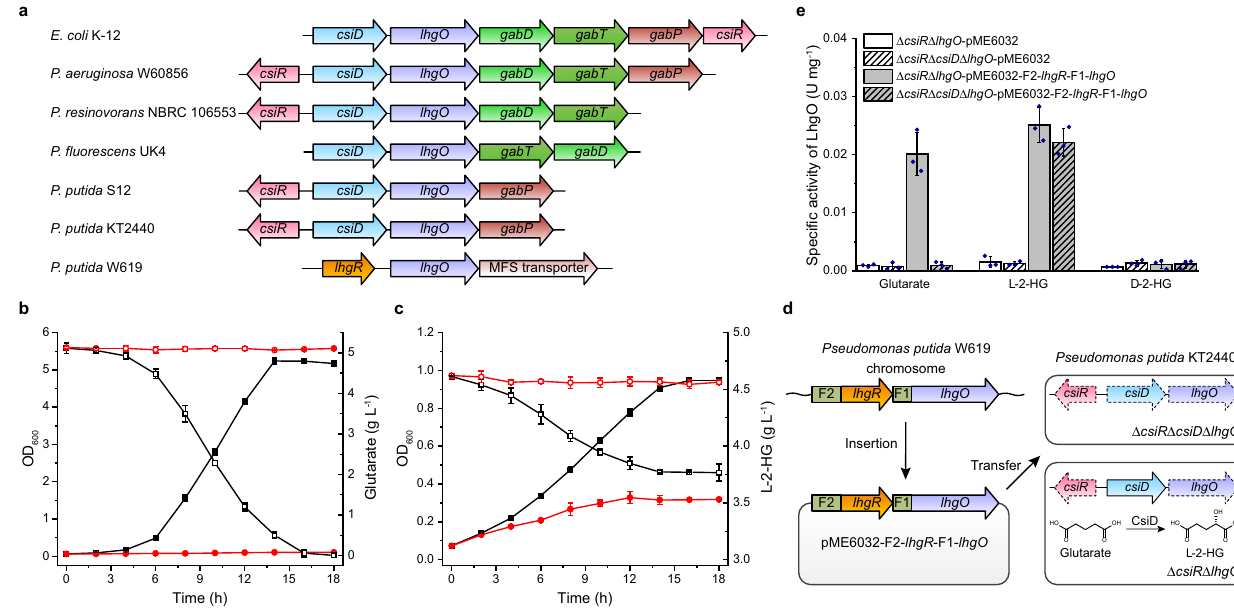
Fig. 1 Regulation of L -2-HG catabolism by LhgR in P. putida W619. a Schematic representation of genomic neighborhood analysis of lhgO in different bacteria. Orthologs are shown in the same color and the direction of gene transcription is indicated by arrows. CsiR, GntR family allosteric transcription factor regulating glutarate catabolism; CsiD, glutarate hydroxylase; LhgO, L -2-HG oxidase; GabD, succinate semialdehyde dehydrogenase; GabT, 4- aminobutyrate aminotransferase; GabP, 4-aminobutyrate transporter. b , c Growth of the derivatives of P. putida KT2440 in MSMs with glutarate ( b ) or L -2- HG ( c ) as the sole carbon source. Growth (closed symbols) and the consumption of carbon source (open symbols) of P. putida KT2440 ( Δ lhgO ) harboring plasmid pME6032- lhgO (black lines with squares) and P. putida KT2440 ( Δ lhgO ) harboring empty plasmid pME6032 (red lines with circles) were measured in MSMs containing 5 g L − 1 glutarate ( b ) or L -2-HG ( c ) as the sole carbon source. d Schematic representation of the construction of pME6032- F2- lhgR -F1- lhgO and its transfer into P. putida KT2440 ( Δ csiR Δ lhgO ) and P. putida KT2440 ( Δ csiR Δ csiD Δ lhgO ) by electroporation. The deleted genes in P. putida KT2440 are indicated by dashed lines. The reaction catalyzed by CsiD is also demonstrated. e The activities of LhgO in P. putida KT2440 ( Δ csiR Δ lhgO ) and P. putida KT2440 ( Δ csiR Δ csiD Δ lhgO ) harboring either plasmid pME6032-F2- lhgR -F1- lhgO or empty plasmid pME6032 grown in MSM with glutarate, L -2-HG, or D -2-HG as the sole carbon source. All data shown are means ± standard deviations (s.d.) ( n = 3 independent